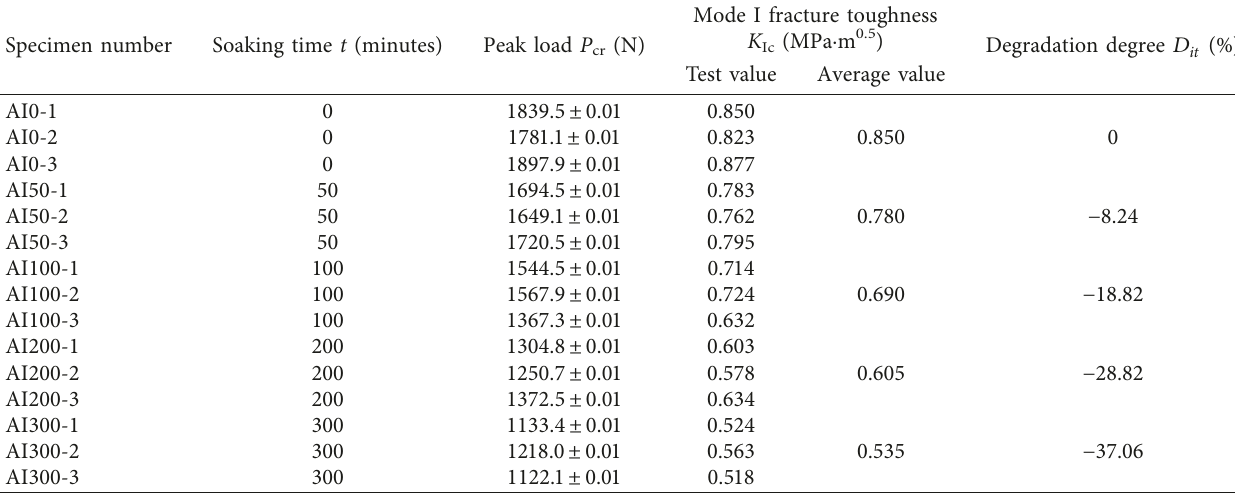
Table 2: Mode I fracture toughness of Type A mudstone specimens for different soaking times.